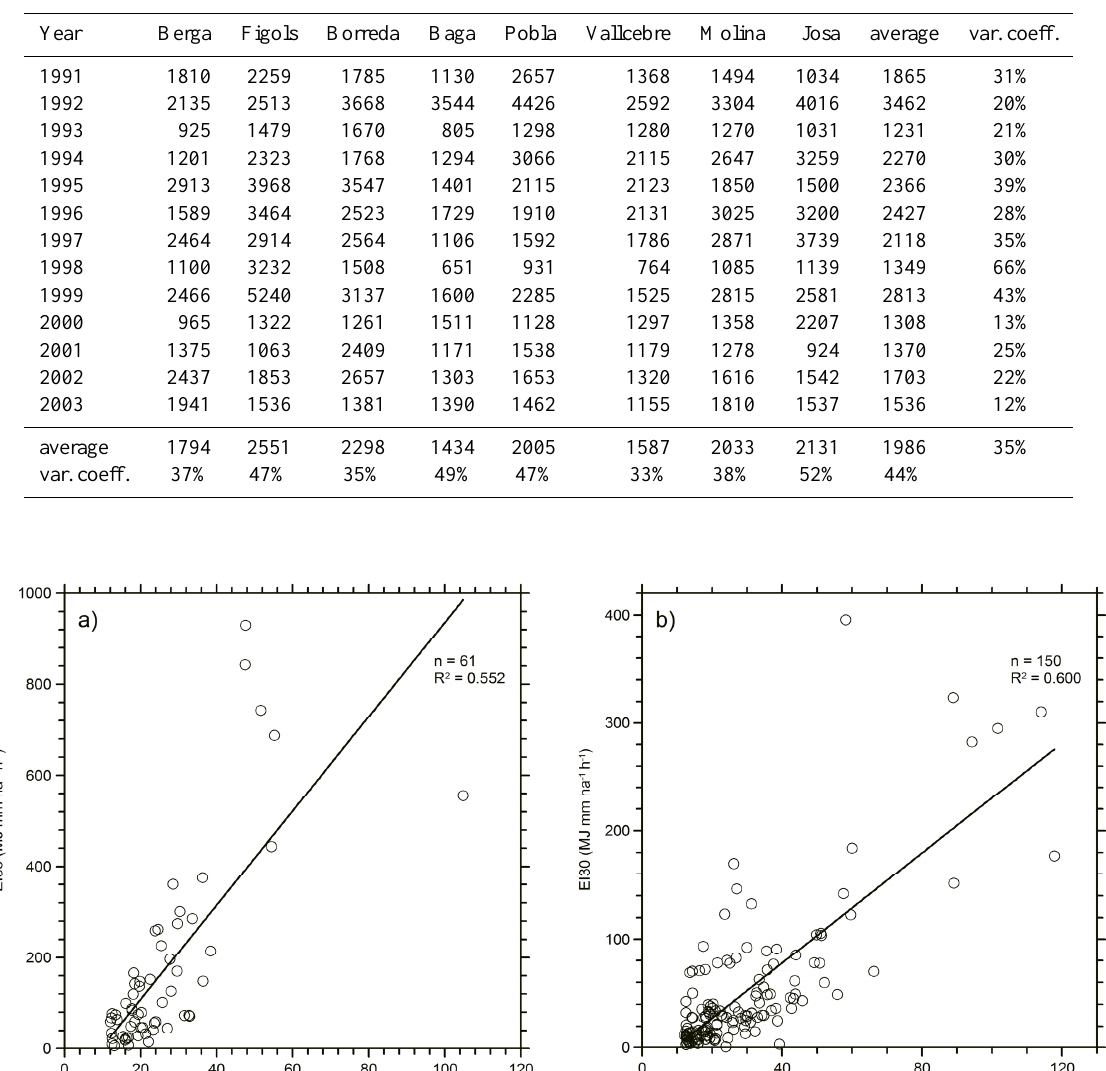
varied between years: coefficients of variations ranged be- tween 12% and 66%, with a mean value of 35%. Never- theless, spatial variability decreased when the inter-annual R values were considered, as the coefficient of variation dropped to 18%. This result may be seen as a consequence of the importance of summer rainstorms in the annual erosivity values. These storms are known to occur a few times every year but not at the same time at all stations, as they cover only a reduced area (Latron et al., 2003). In the long term, spatial variability is reduced because of the random spatial occurrence of storms.